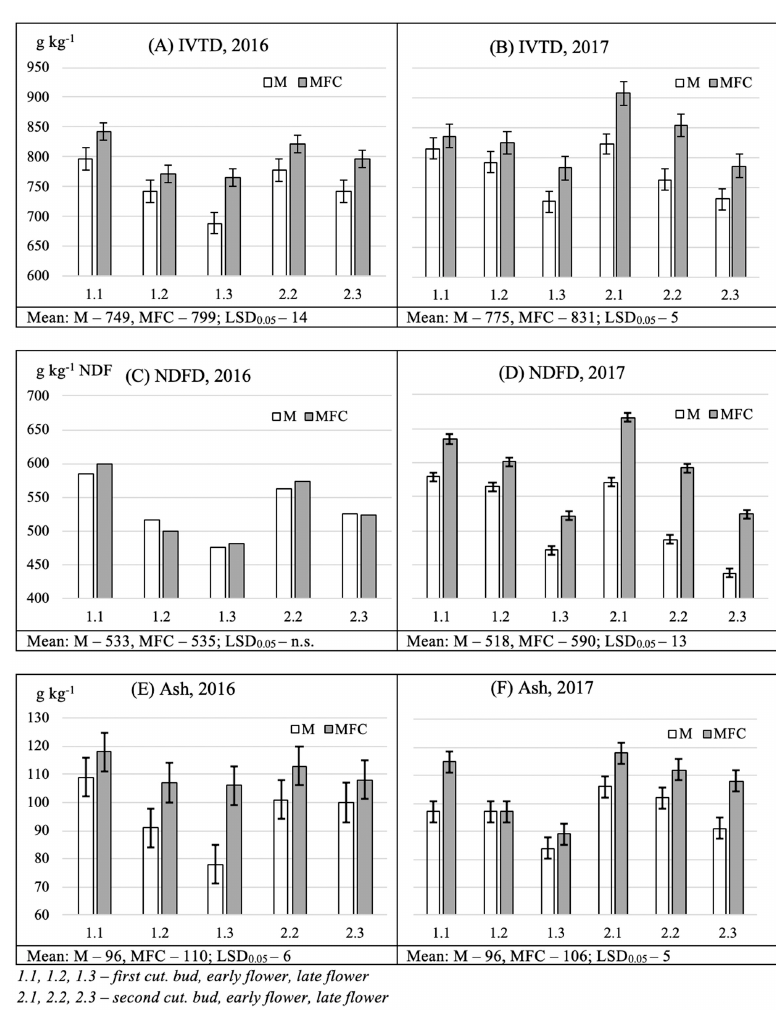
Figure 2. ( A , B ) in vitro true digestibility (IVTD), ( C , D ) neutral detergent fiber digestibility (NDFD) and ( E , F ) ash concentration of alfalfa harvested with a sickle-bar mower (M) or modified flail chopper (MFC) dependent on cut and plant development stage. The bars indicate LSD ( p = 0.05) values for comparing means across harvest methods and event ( D ) or between harvest methods within harvest event ( A , B , E , F ) where harvest method X harvest event interaction was